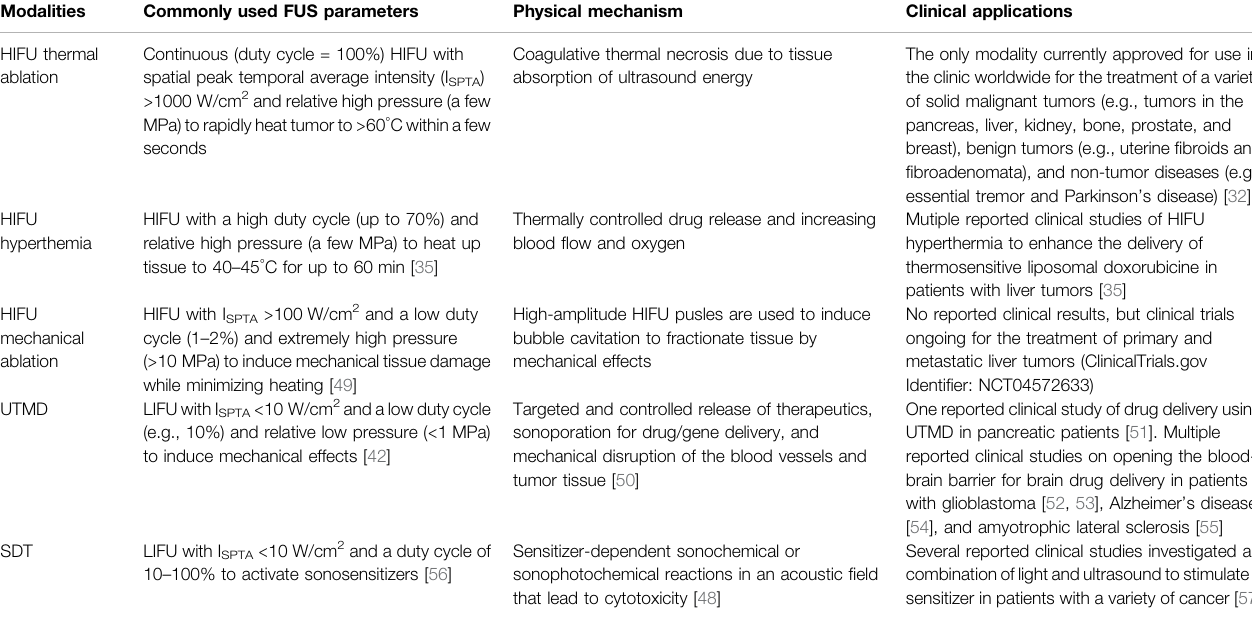
TABLE 1 | Overview of different FUS modalities. Modalities Commonly used FUS parameters Physical